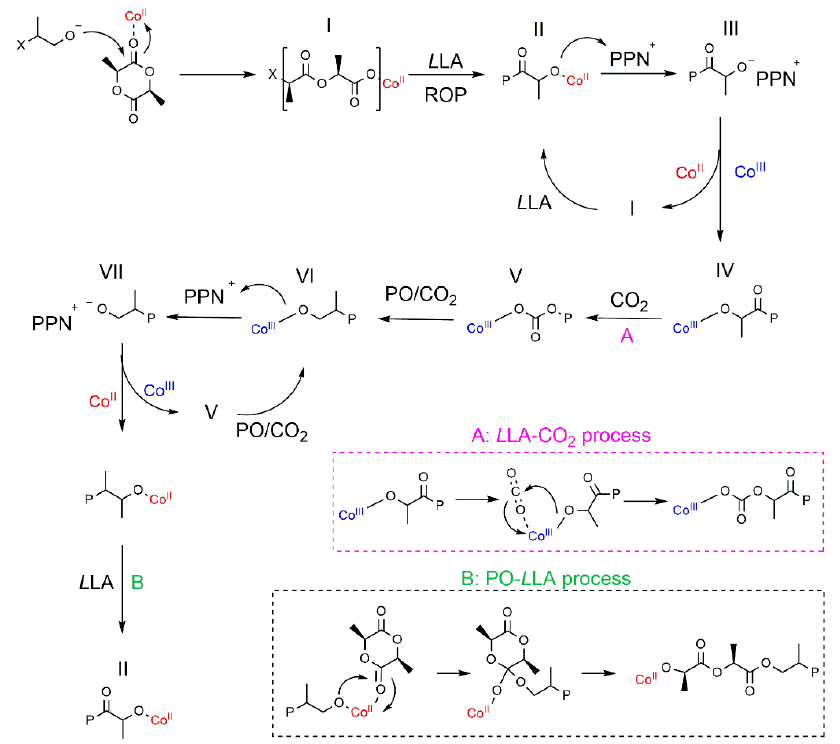
Figure 12. Structures of salenCo II complexes ( 30a – 32a ) and salenCo III complexes ( 30b – 32b ) [57]. Indeed, the Co(II) complexes ( 30a – 32a ) are active in the ROP of LA, and the Co(III) complexes ( 30b – 32b ), in combination with PPNCl, are active in the ROCOP of CO 2 with various epoxides (PO, CHO, SO). The terpolymerization was possible for the chain trans- fer between the two metal centers (Scheme 8).